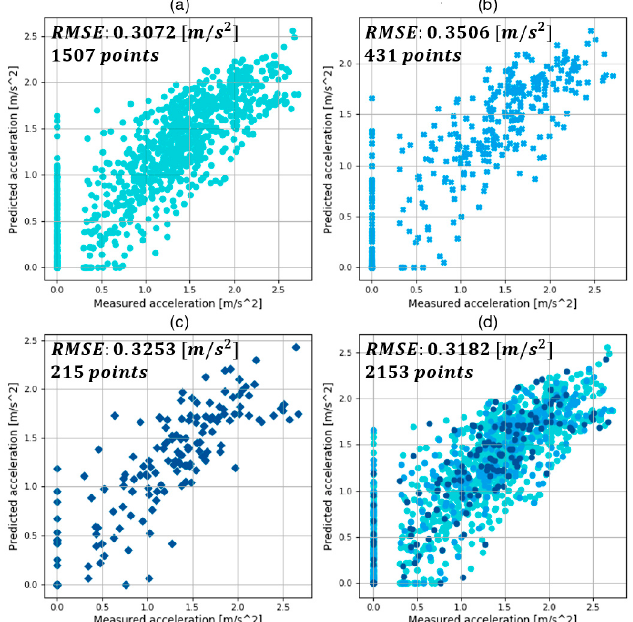
Figure 11. Results of ( a ) training; ( b ) validation; ( c ) test; ( d ) and total using the best model in speed hump conditions.